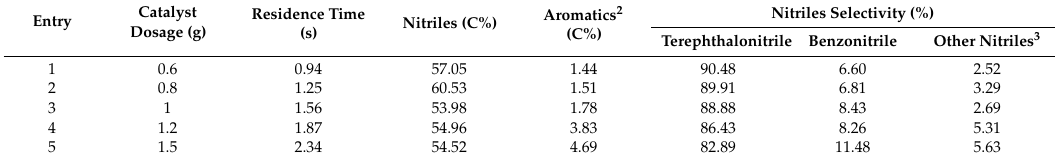
Figure 2. Effect of Ca(OH) 2 loading on Ca(OH )2 -Al 2 O 3 catalysts on ( a ) overall yield and ( b ) nitriles selectivity for selectively producing terephthalonitrile via the catalytic fast pyrolysis of PET with Table 1. E ff ect of residence time between pyrolytic vapors and catalyst. 1.